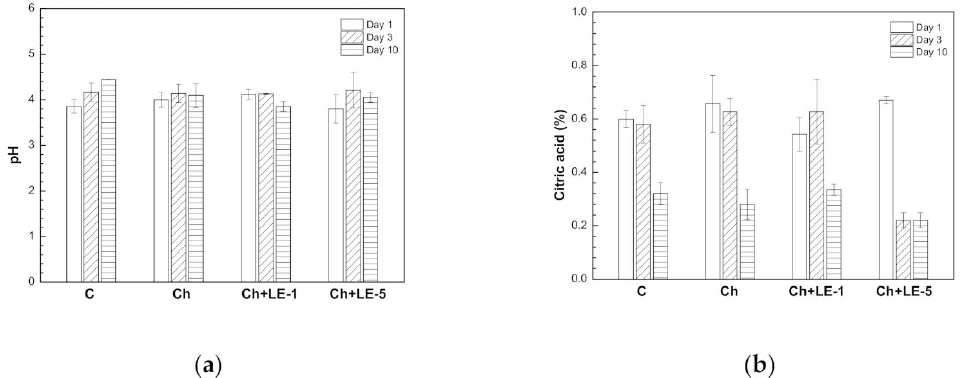
Figure 8. E ff ect of di ff erent coatings based on chitosan and licorice extracts on ( a ) pH and ( b ) titratable acidity (TA) expressed as citric acid percentage of strawberries stored for 10 days at 4 ◦ C. C = uncoated; Ch = chitosan; Ch + LE-1 = Chitosan + 1% of licorice extract; Ch + LE-5 = Chitosan + 5% of licorice extract. Means values and intervals of Tukey’s test at 95% according to the analysis of variance (ANOVA)